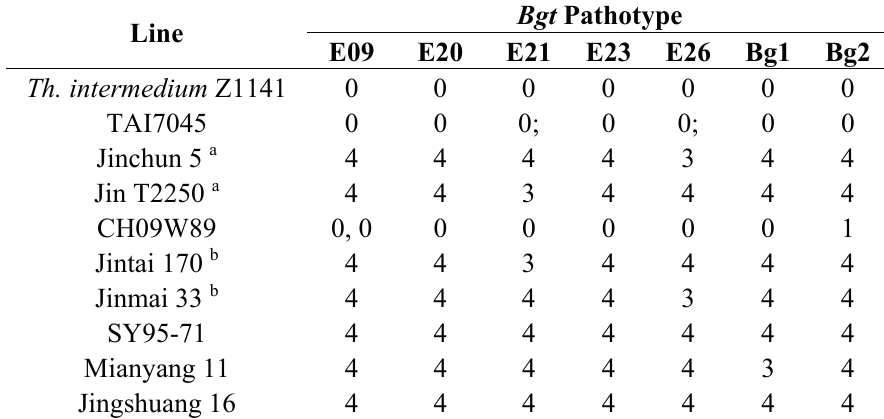
Table 1. Seedling infection types (IT) on selected donor lines, parents, and controls to seven Bgt pathotypes.